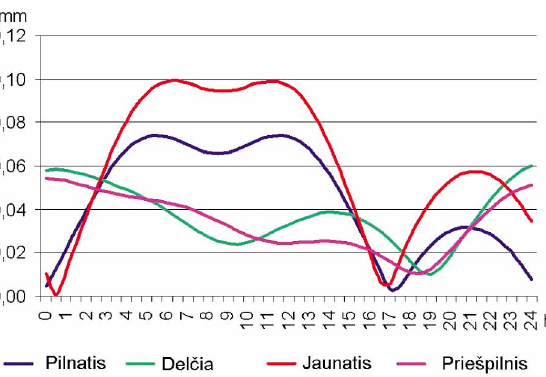
Fig. 4. Correction dependency on azimuth change at different time moments